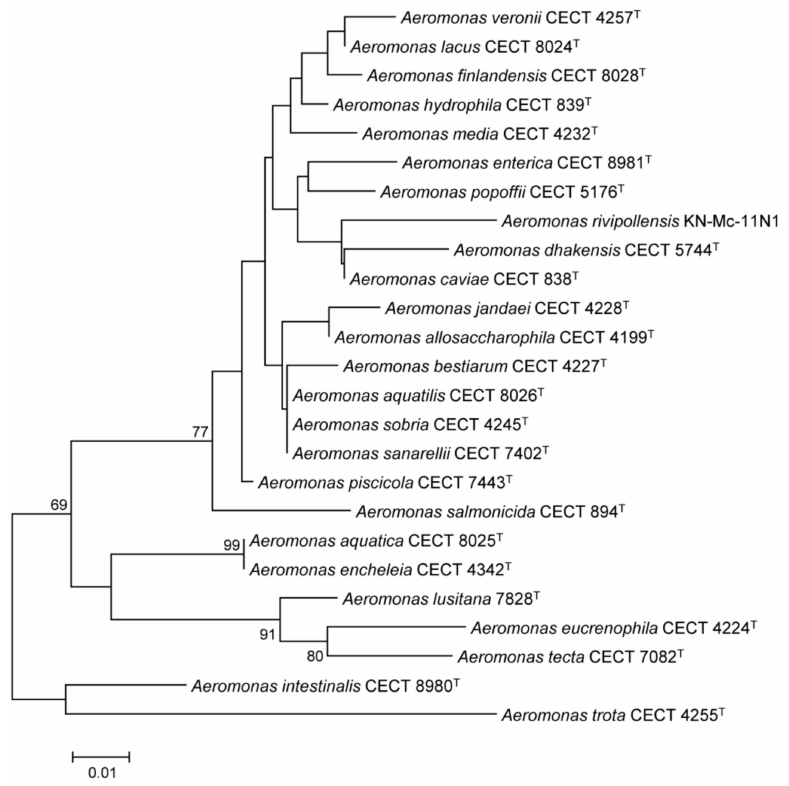
Figure 2. Phylogenetic tree constructed with the in silico-translated amino acid sequences of HypA proteins (113 aa) from 36 Aeromonas species type strains (the only sequence not belonging to the type strain corresponds to A. rivipollensis KN-Mc-11N1). The phylogenetic analysis was constructed with MEGA6, using Neighbor-joining algorithm. Numbers at nodes represent bootstrap percentages ( > 50%) obtained by repeating analysis 1000